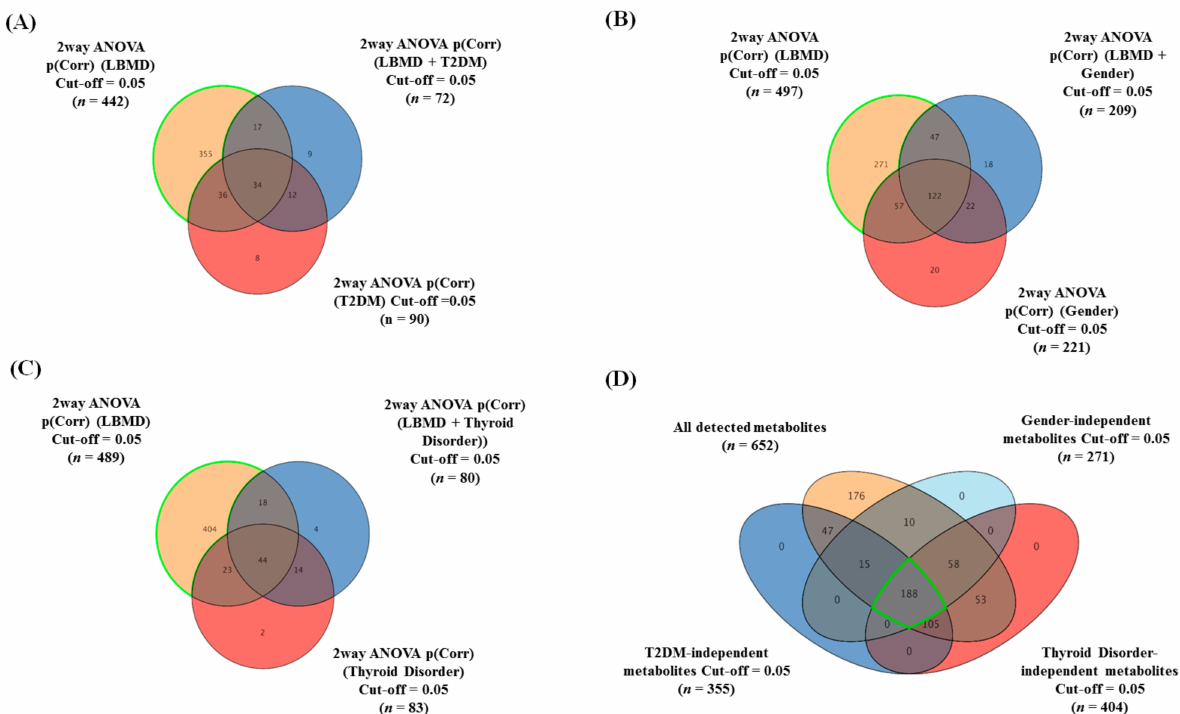
Figure 1. Determination and exclusion of primary confounder (T2DM, gender, and thyroid disease)-related metabolites from the overall detected metabolites. The panels from ( A – C ) show Venn diagrams displaying the number of significantly altered metabolites in patients with LBMD, regardless of the effects of primary confounders (T2DM, gender, and thyroid disease), using two-way ANOVA statistical analysis with an FDR-corrected p -value cutoff = 0.05. ( A ) The highlighted metabolites depict the number of T2DM-independent metabolites ( n = 355) from 442 metabolites significantly dysregulated due to the LBMD combined with T2DM. ( B ) The highlighted metabolites depict the number of gender-independent metabolites ( n = 271) from a group 497 metabolites significantly dysregulated due to LBMD combined with gender. ( C ) The highlighted metabolites depict the number of thyroid disease-independent metabolites ( n = 404) from a group 489 metabolites significantly dysregulated due to LBMD combined with thyroid disease. ( D ) Venn diagram illustrating overlapping among the confounder (T2DM, gender, and thyroid disease)-independent metabolites with the overall detected metabolites ( n = 652), considering a corrected p -value cutoff = 0.05; 188 metabolites were found to remain after exclusion and were considered as significantly connected to LBMD (primary confounder-independent